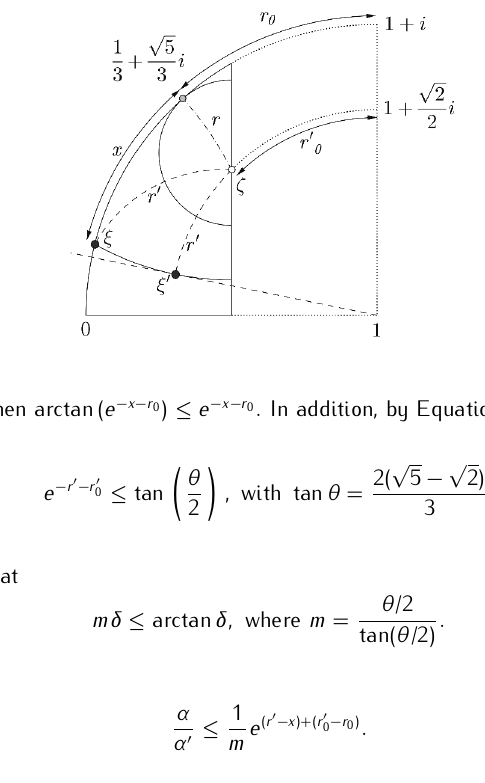
Figure 17. Values used in the proof of Proposition